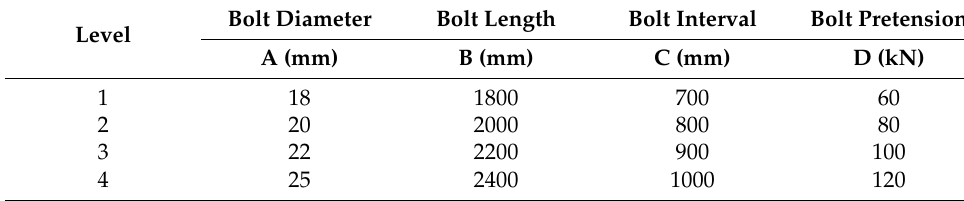
Table 3. The factor scheme of the orthogonal numerical simulation experiment.